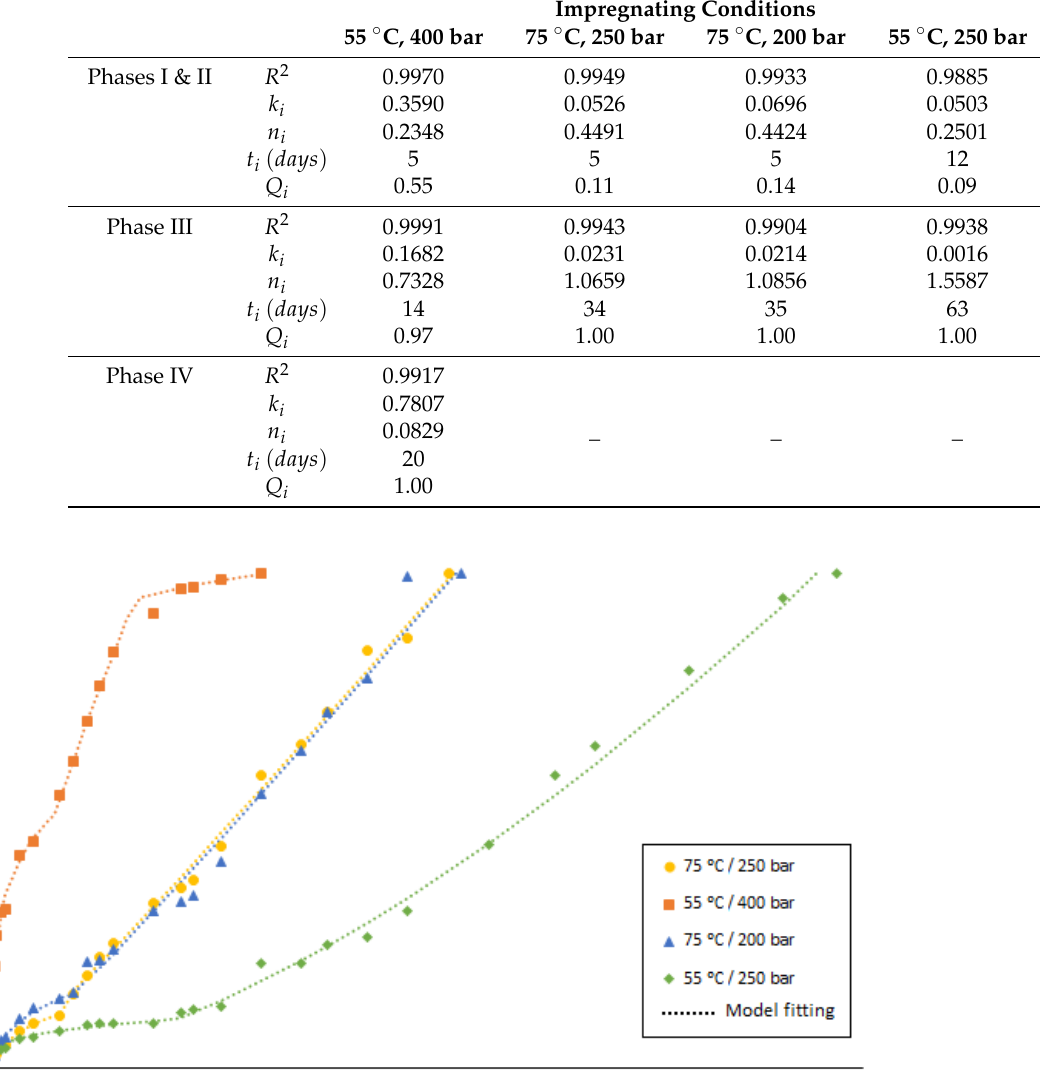
Table 7. Model parameters and R-squared values obtained from the fitting of the ketoprofen- impregnated PLA filaments to the multiphasic power law model proposed in this work.